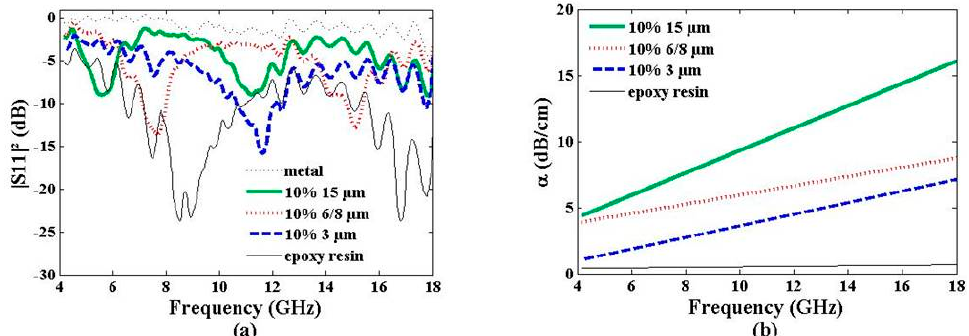
Figure 5. Reflected power |S 11 |² ( a ) and electromagnetic absorption α ( b ) vs. frequency of epoxy resin loaded with different graphene particle sizes at a constant weight ratio (10%). Pristine epoxy resin values are given for reference.